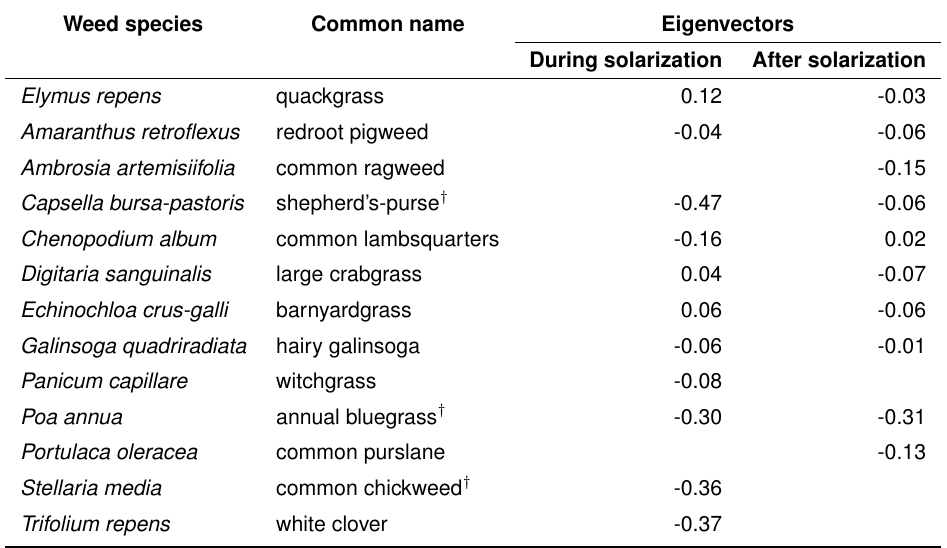
Table 3. Coefficients of linear discrimination (eigenvectors) showing the contribution of weed species to overall community separation during and after two weeks of spring solarization.